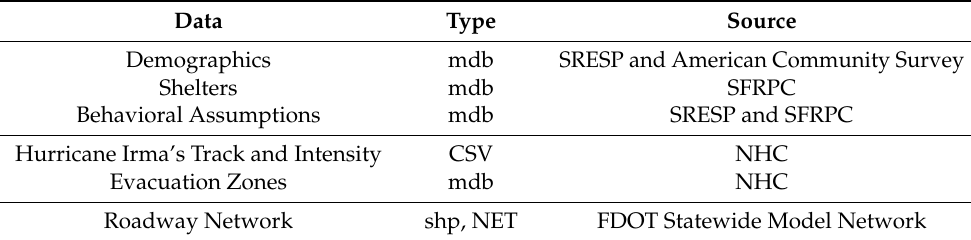
Table 1. Data types and